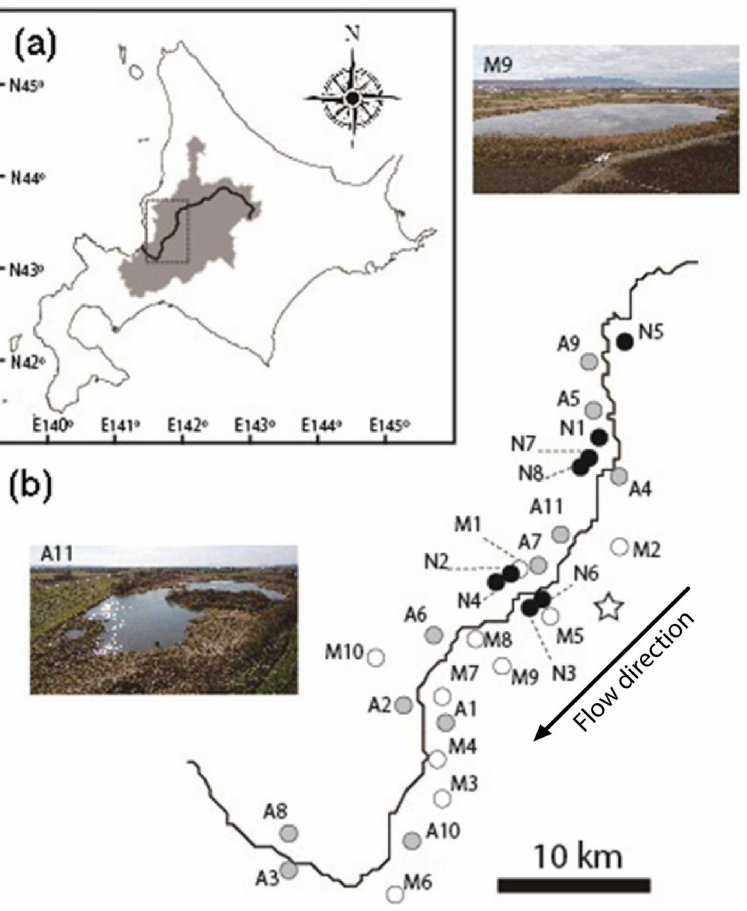
Figure 1. ( a ) The main channel (shown within the shaded area) of the Ishikari River in Hokkaido, northern Japan. ( b ) Locations of three types of floodplain water bodies: gray, black and open circles indicate artificially formed oxbow lakes (A), naturally formed oxbow lakes (N) and marsh lakes (M), respectively. Identification labels were attached to each of the circles; see Table 1 for more details. A star denotes a weather station of the Japan Meteorological Agency where data of precipitation and temperature were obtained. Bird-view pictures represent two example water